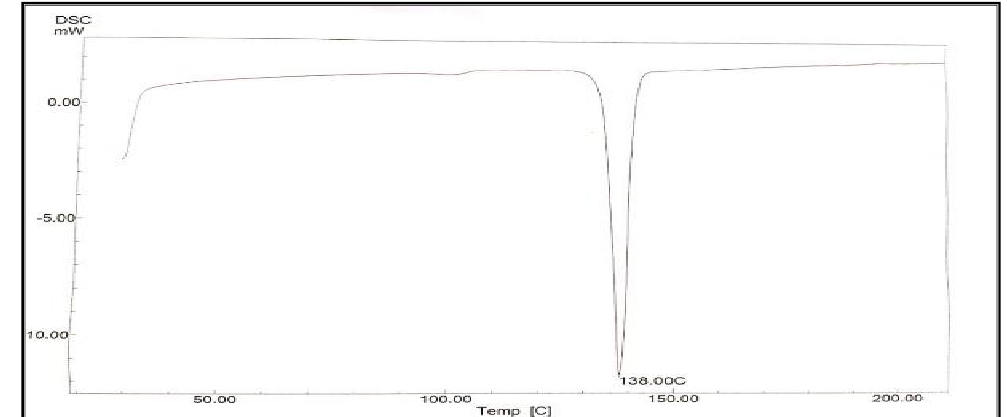
Figure 11.The DSC thermogram of